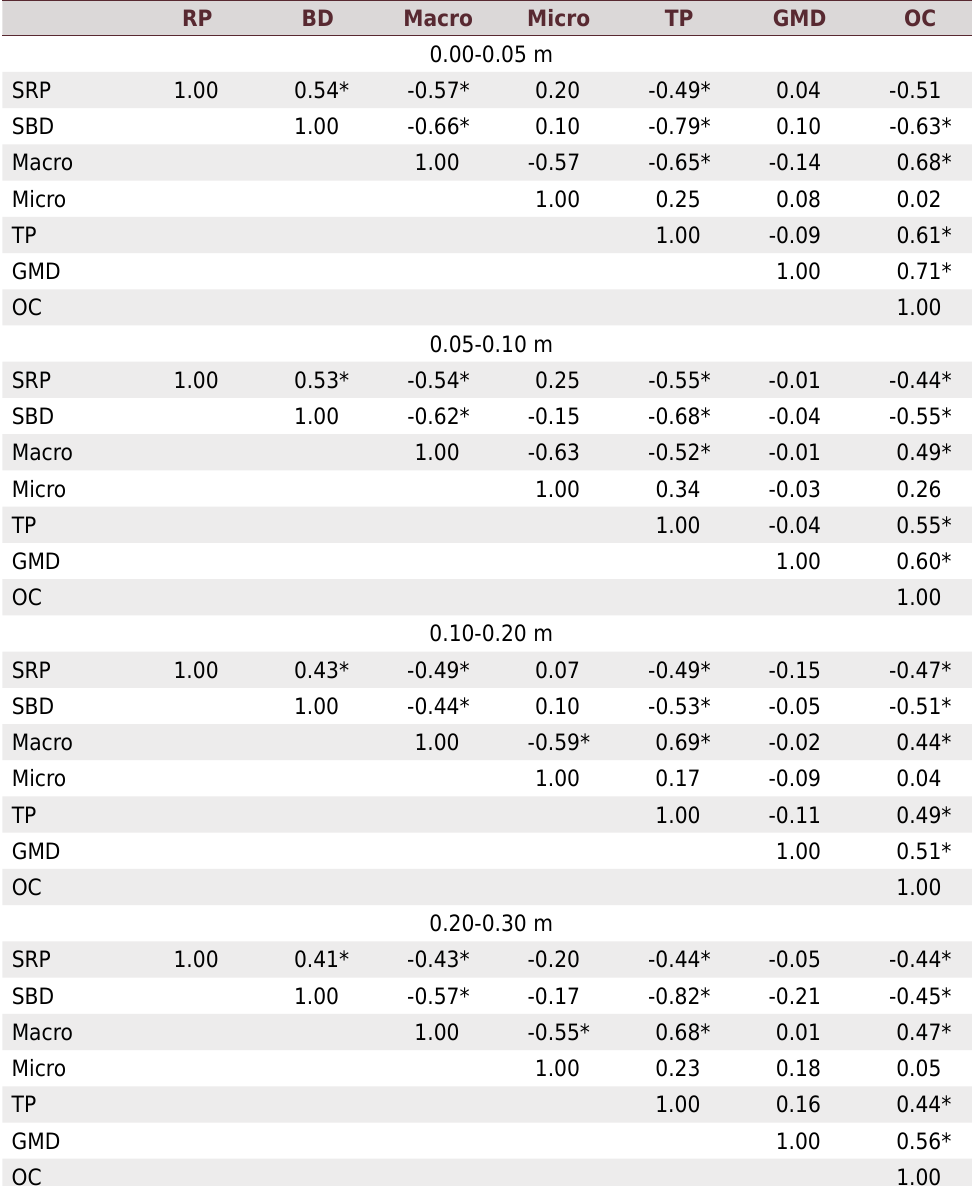
Table 5. Coefficients of correlation among the soil properties (n = 352), for four soil layers, in areas of Archaeological Dark Earth under cacao cultivation RP